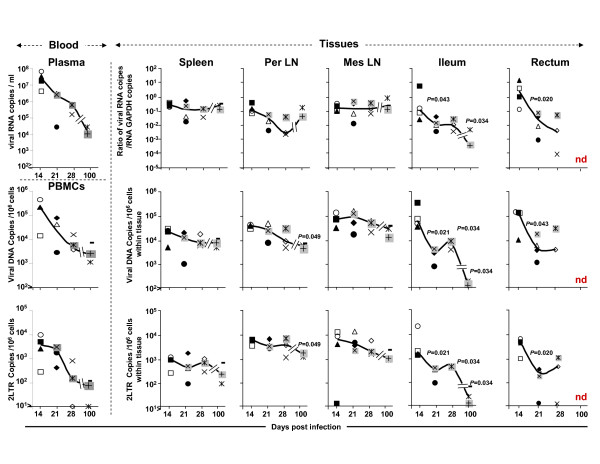
Viral replication and dissemination in the tissues of macaques during primary infection with SIVmac251. The three viral markers -- viral RNA, DNA and 2 LTR circles -- were evaluated in various tissues from macaques infected with SIVmac251, on days 14, 21, 28 and 100 pi. The relative level of viral RNA with respect to the mRNA for GAPDH was calculated by the "delta delta Ct" method. Absolute copy numbers for viral DNA and 2LTR circles were calculated to the GAPDH and normalized to one million of cells. When significant, p values were indicated. The results from blood were added to tissues as comparative value.